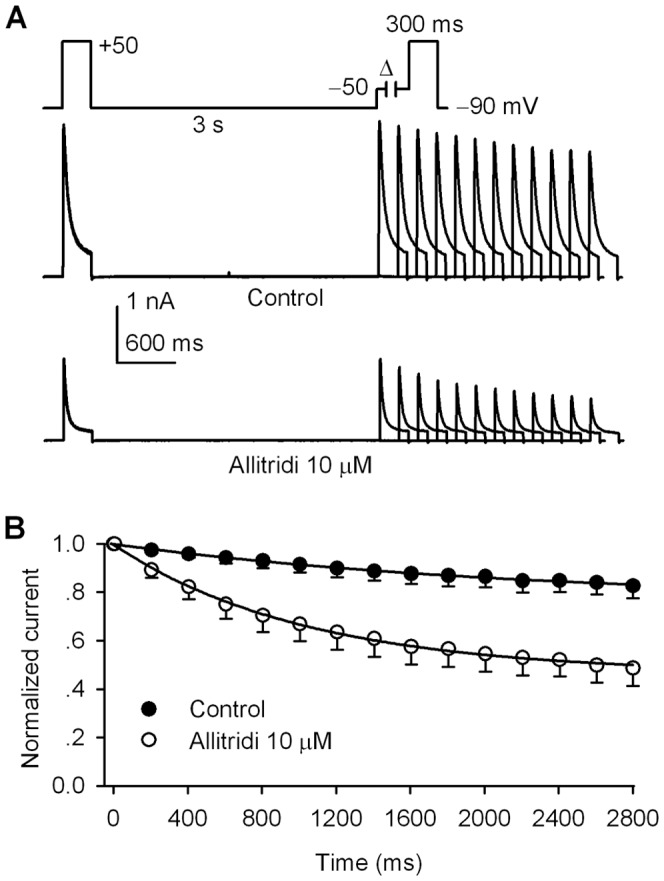
Effect of allitridi on closed-state inactivation of hKv4.3 current.
A. The hKv4.3 current traces recorded by the voltage protocol (inset) used for determining closed-state inactivation kinetics of the channel in the absence (control) and presence of 10 µM allitridi. B. Mean values (n = 6) of time course of the closed-state inactivation of hKv4.3 current was fitted to a monoexpontial equation before (control) and after application of 10 µM allitridi.